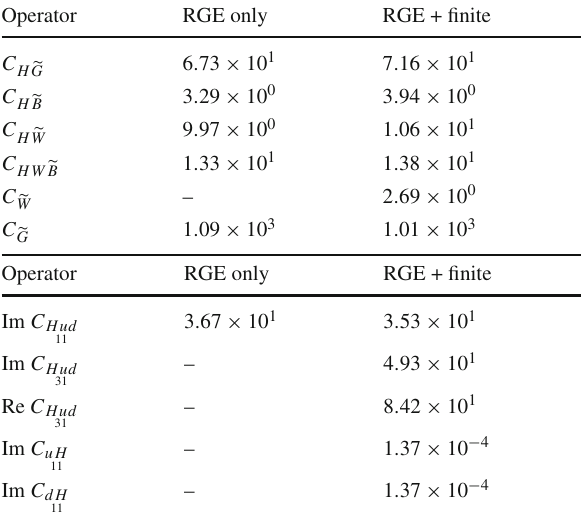
also includes 11